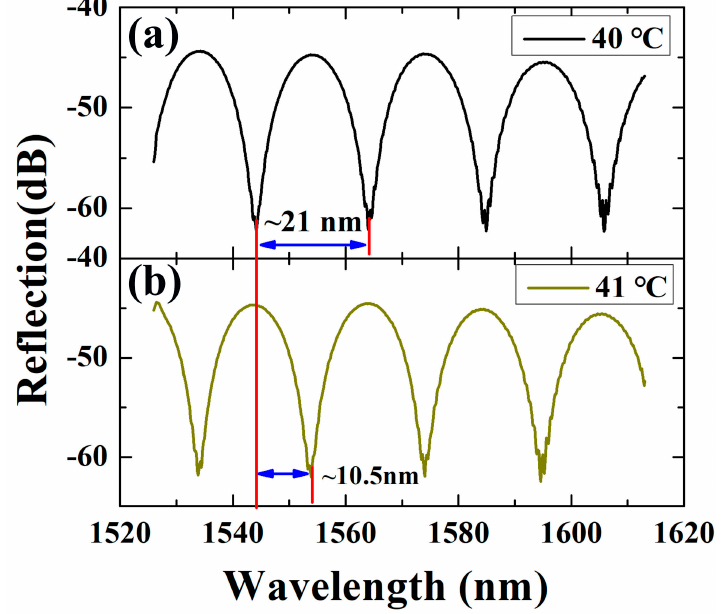
Figure 3. Reflection spectra of the microfiber Fabry-Perot temperature probe at temperature of ( a ) 40 °C and ( b ) 41 °C, respectively.